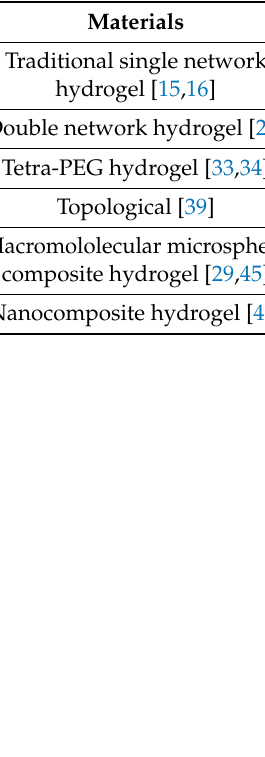
Figure 4. Using poly (lactic acid-glycolic acid) (PLGA), magnesium oxide (MgO), and magnesium carbonate (MgCO 3 ) as raw materials, a series of PLGA \ MgO \ MgCO 3 (PMg) composite microspheres were prepared by the emulsion method. Controlled release of Mg 2+ [39]. Table 1. Mechanical properties and examples of several hydrogels